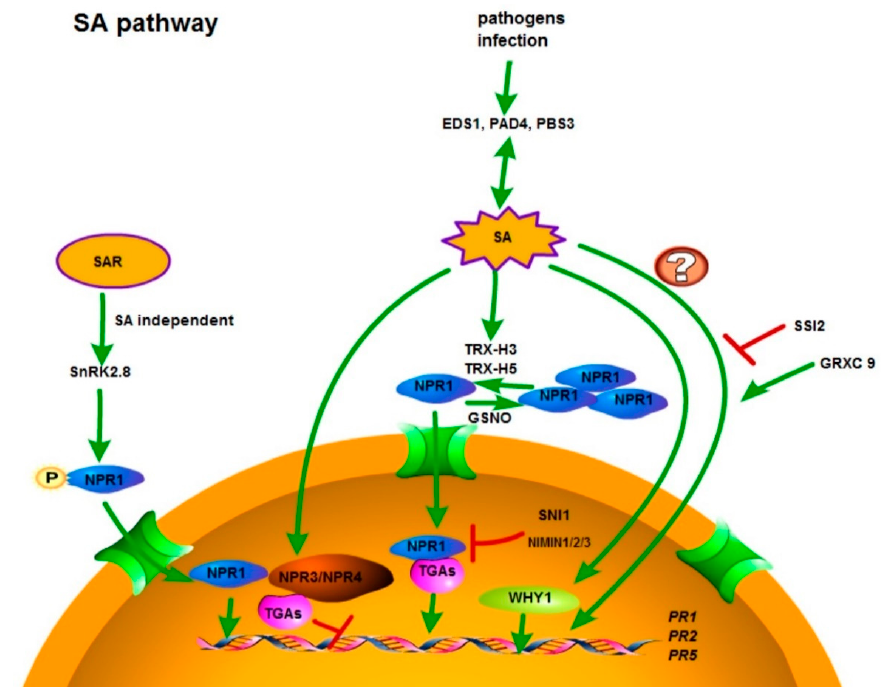
Figure 1. Model of salicylic acid (SA) synthesis and SA signal transduction. Enhanced